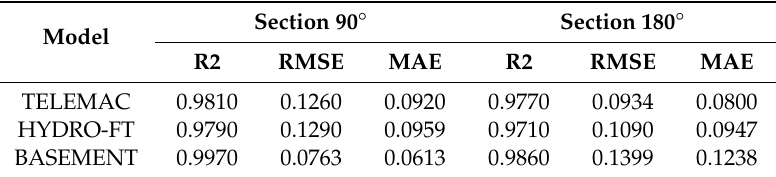
Table 5. Statistical performance of each model at 90 ◦ and 180 ◦ sections. Model